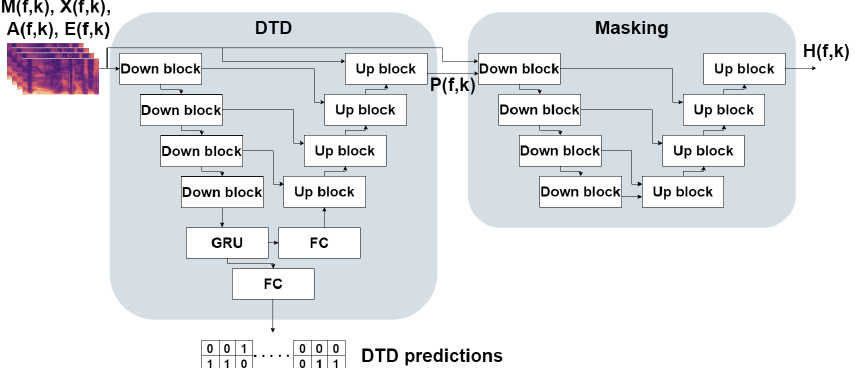
Figure 2. Structure of the double-talk detector (DTD) and masking model architecture. FC stands for fully